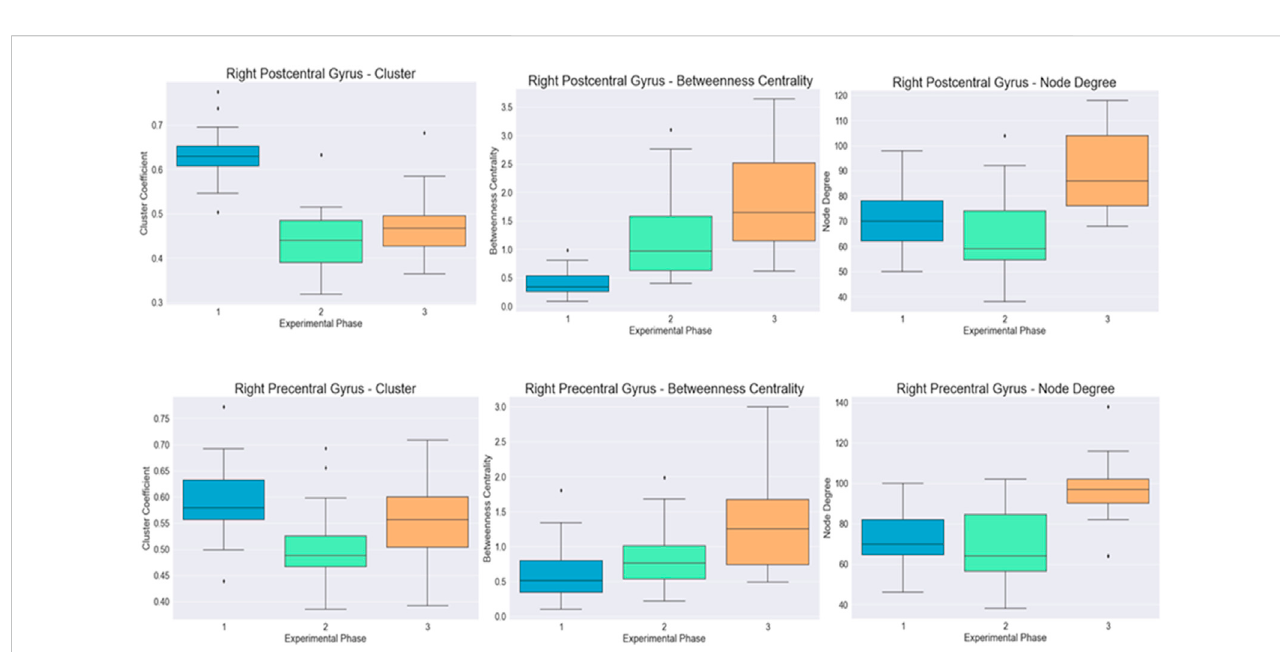
FIGURE 4 Visualization of the distribution of the cluster coef fi cient, betweenness centrality, and node degree for the right postcentral and right precentral gyrus across the three-time instances during the experimental phase, where “ 1 ” stands for before SAHC, “ 2 ” stands for SAHC alone in both protocols, and “ 3 ” stands for SAHC combined with exercise. For clari fi cation, both AG alone or if combined with exercise is considered treatment. So, the only “ pre ” period is before centrifugation, and every protocol after that stands for “ post.